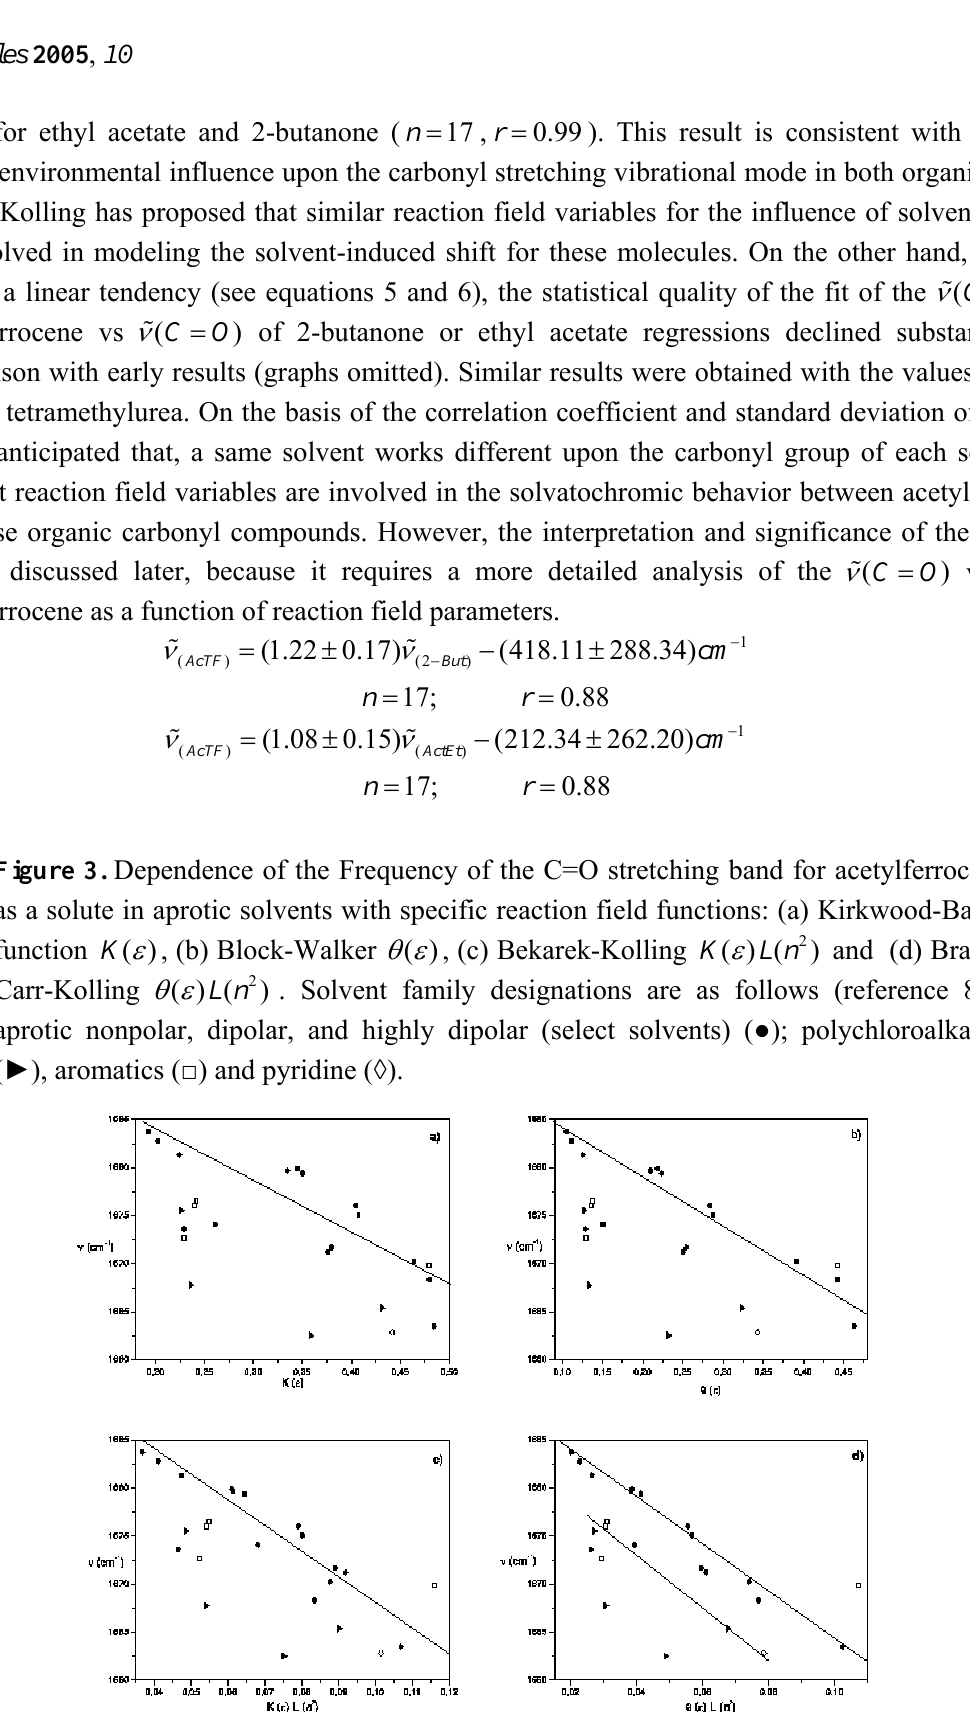
( ► ), aromatics ( □ ) and pyridine ( ◊